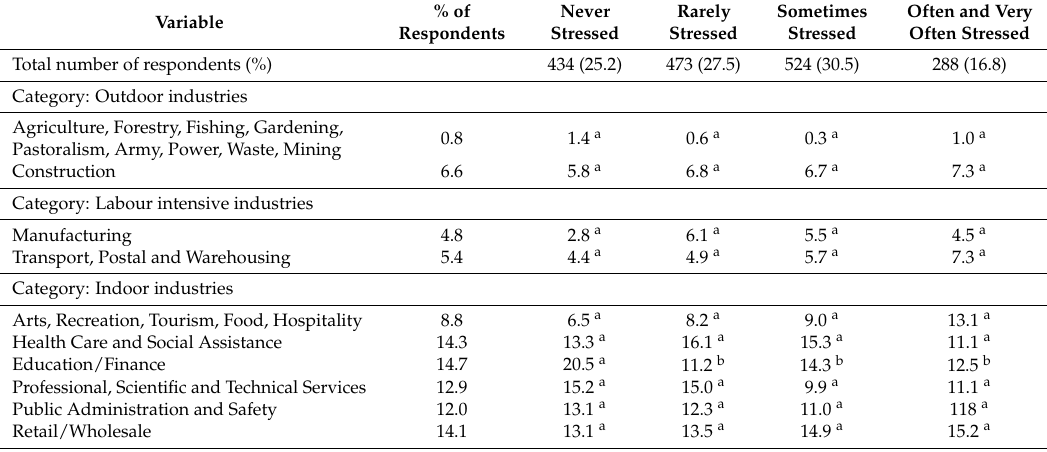
Table 2. Degree of heat stress varying across different variables (N = 1719)—results from bivariate analyses. Variable